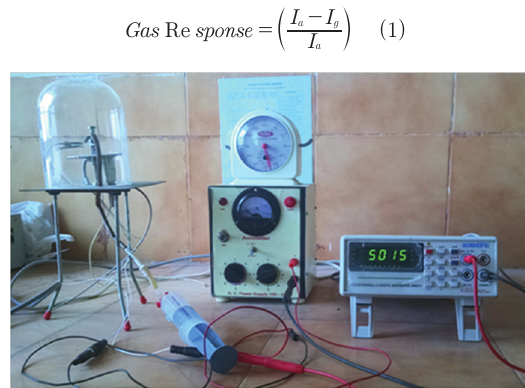
Figure 1. Photographic view of gas sensing setup.